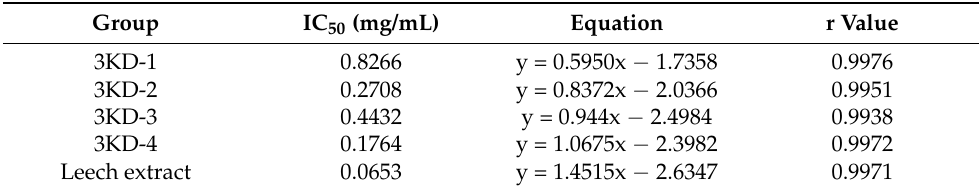
Table 2. IC 50 values and calculation equation of ACE inhibitory activity in different groups. Group IC 50 (mg/mL) Equation r